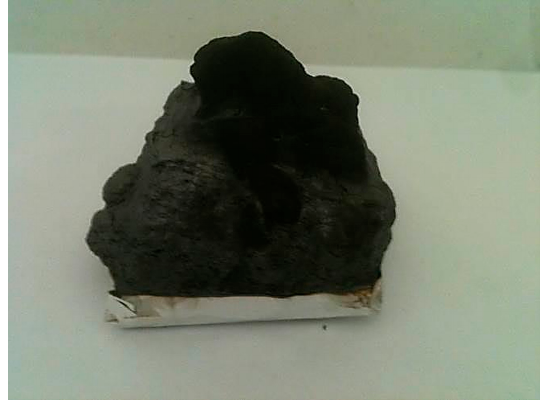
Figure 9. Residue of HT/E-15APP after cone calorimetry tests.